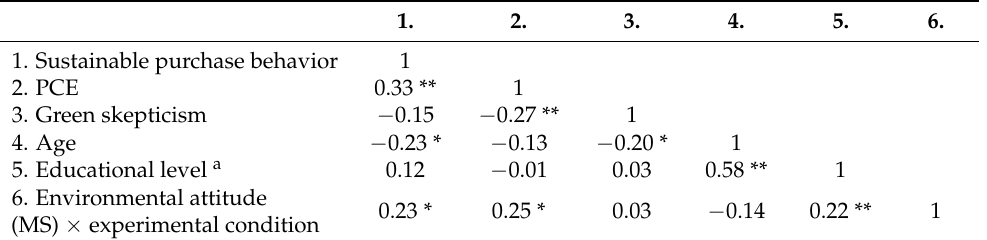
Table 3. Pearson correlations between the continuous variables.